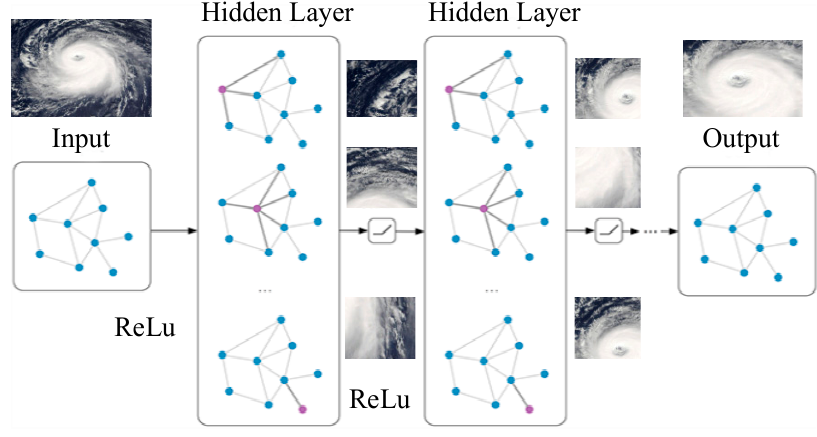
Figure 5. Schematic diagram of Graph Convolutional Network (GCN) structure.